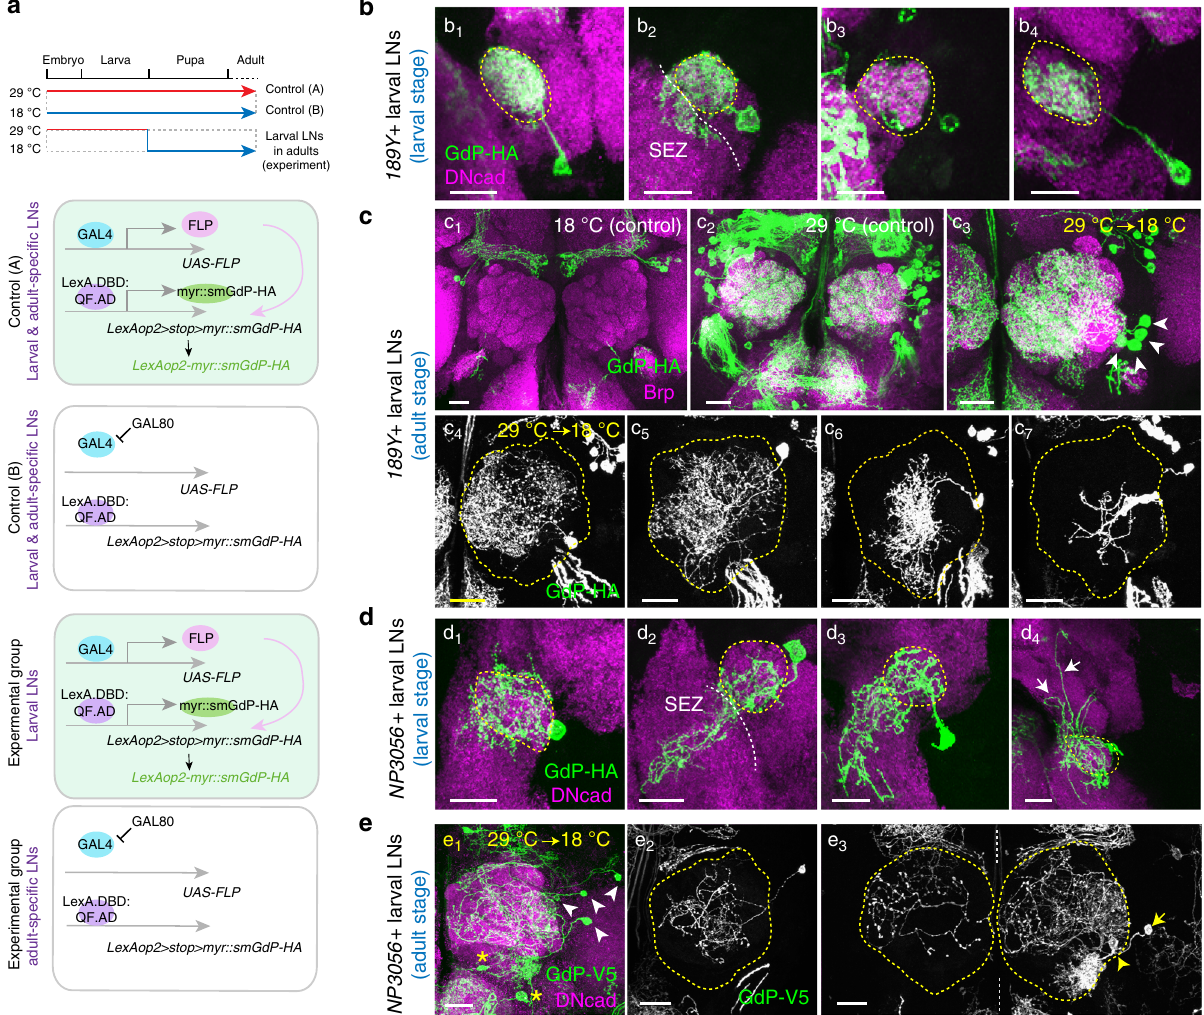
Fig. 4 Larval LNs acquire different morphologies in adult ALs compared to larval patterns. a Scheme of two binary systems that together drive myr::smGdP reporter expression exclusively in larval LNs within adult brains. b 189Y -larval LNs show distinct morphologies in late 3rd instar larval brains. Four types of LNs were observed, as shown in b 1 ( n = 22/68 SCCs), b 2 , ( n = 30/68 SCCs), b 3 ( n = 9/68 SCCs), and b 4 ( n = 7/68 SCCs). Supplementary Note 3 contains detailed descriptions of larval LNs in b and d . Yellow and white dashed lines contour ALs and SEZ, respectively. c The morphologies of 189Y - positive larval LNs in adult brains. c 1 Negative control fl ies were maintained at 18 °C throughout development, and no smGdP-labeled LNs were observed in adult brains ( n = 43 brains). c 2 When fl ies were raised at 29 °C throughout development, both larval and adult-speci fi c LNs were labeled ( n = 26 brains). c 3 – c 7 When fl ies were raised at 29 °C from embryonic stage and shifted to 18 °C at puparium formation, as many as four LNs were observed in the adult brains (arrowheads, n = 17 brains) (c 3 ). These LNs may have processes in dorso-medial glomeruli (c 4 ) or central glomeruli (c 5 ). Otherwise they may pack densely in a small subset of central glomeruli (c 6 ) or sparsely innervate multiple glomeruli (c 7 ). ALs are contoured by yellow dashed lines. d NP3056 -larval LNs show distinct morphologies in late 3rd instar larval brains. The four types of LNs are shown in d 1 ( n = 21/86 SCCs), d 2 ( n = 24/86 SCCs), d 3 ( n = 25/ 86 SCCs), and d 4 ( n = 16/86 SCCs). Arrows indicate LN processes in dorsal brain regions. e Similar to c but for NP3056 -GAL4. When fl ies were shifted to 18 °C at puparium formation, as many as four LNs were observed in adult brain (arrowheads, n = 54 brains) (e 1 ). These LNs may have processes that cover the central AL (e 2 ), innervate both ALs (e 3 , arrow, bilateral LN), or the neuron may innervate VP1, VP2, and VP3 (e 3 , arrowhead, oligo-glomerular LN). Asterisks denote neurons that are not